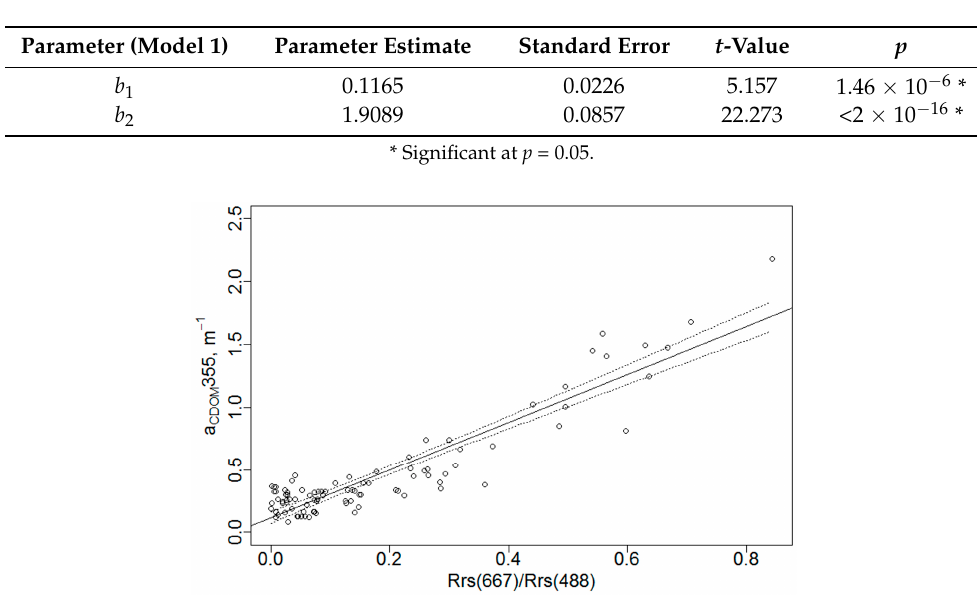
Table 4. Results of the OLS regression of Model 1 on the test data set.